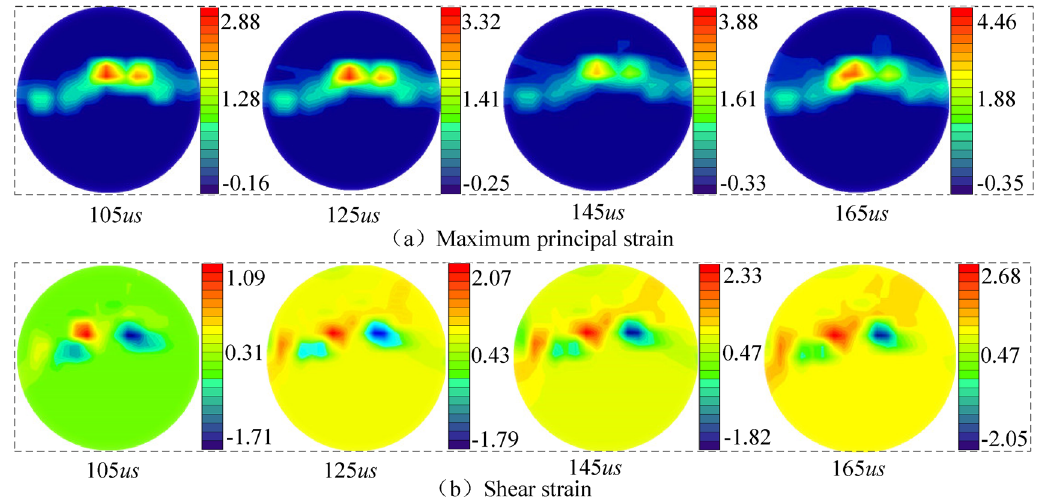
Figure 10. Strain field distribution in natural coal sample at loading pressure of 0.30 MPa.